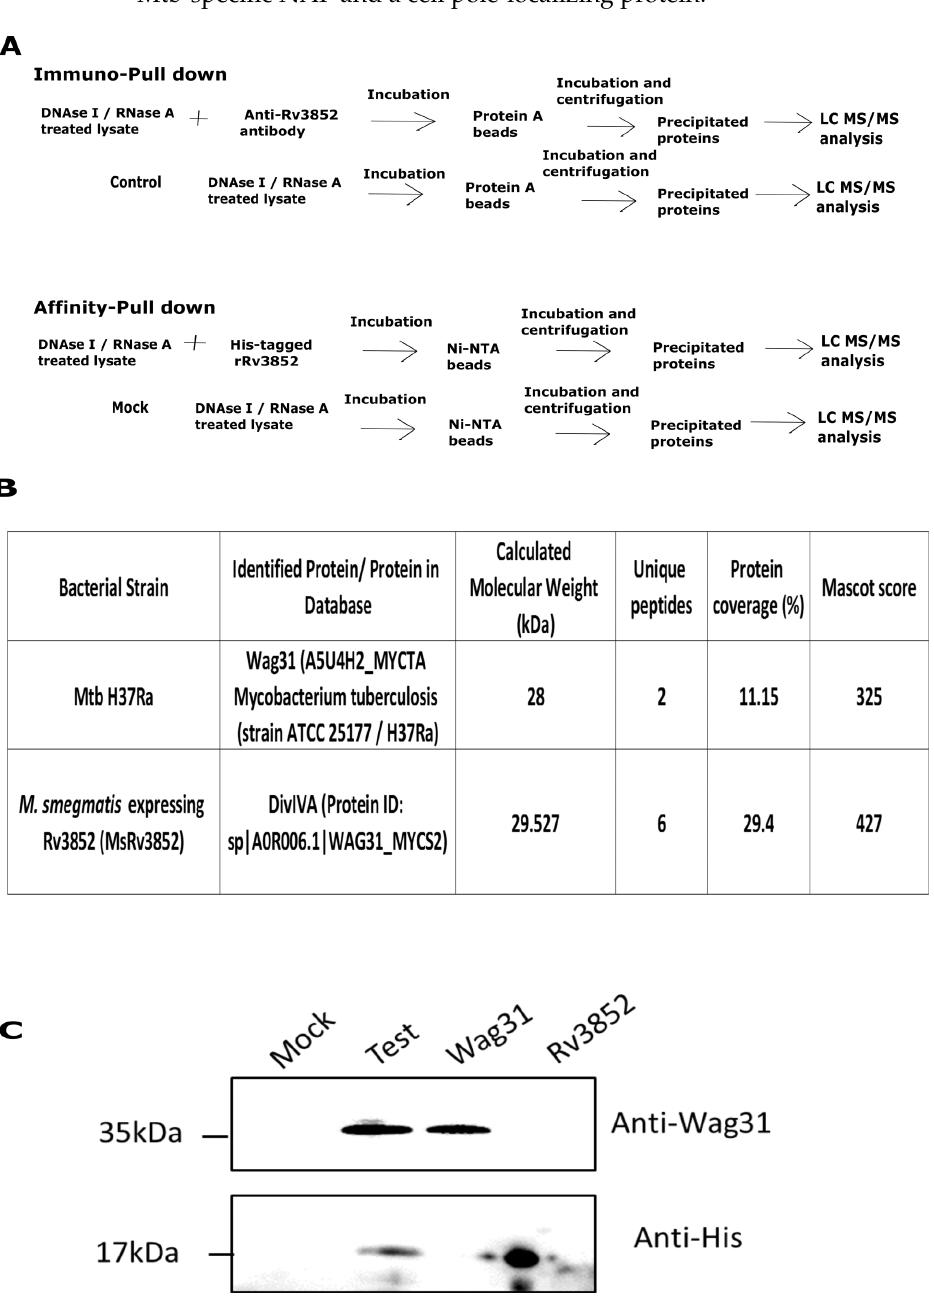
Figure 1. Identification of Wag31 as an interacting partner of Rv3852 in Mtb. ( A ) Schematic representation of immuno pull-down and affinity pull-down strategy. DNase I and RNase A-treated lysate was incubated with anti-Rv3852 antibody-coated protein A beads (immuno pull-down) or hexa-histidine tagged, Rv3852-coated Ni-NTA beads (affinity pull-down). The subsequent steps were carried out as indicated. Wag31 and DivIVA Msm were immuno-precipitated from Mtb H37Ra and MsRv3852 lysates, respectively, using immuno pull-down. ( B ) Table shows the number of peptides, protein coverage, and mascot score for Wag31 and DivIVA Msm obtained from nano-LC–MS/MS analysis from both the samples. ( C ) Immunoblot showing the interaction of hexa-histidine-tagged Rv3852 with Wag31, seen by affinity pull-down strategy outlined in (A). Mock reaction contains non-spiked lysate, while test reaction contains lysate spiked with hexa-histidine-tagged Rv3852. Wag31 and Rv3852 lanes show respective purified